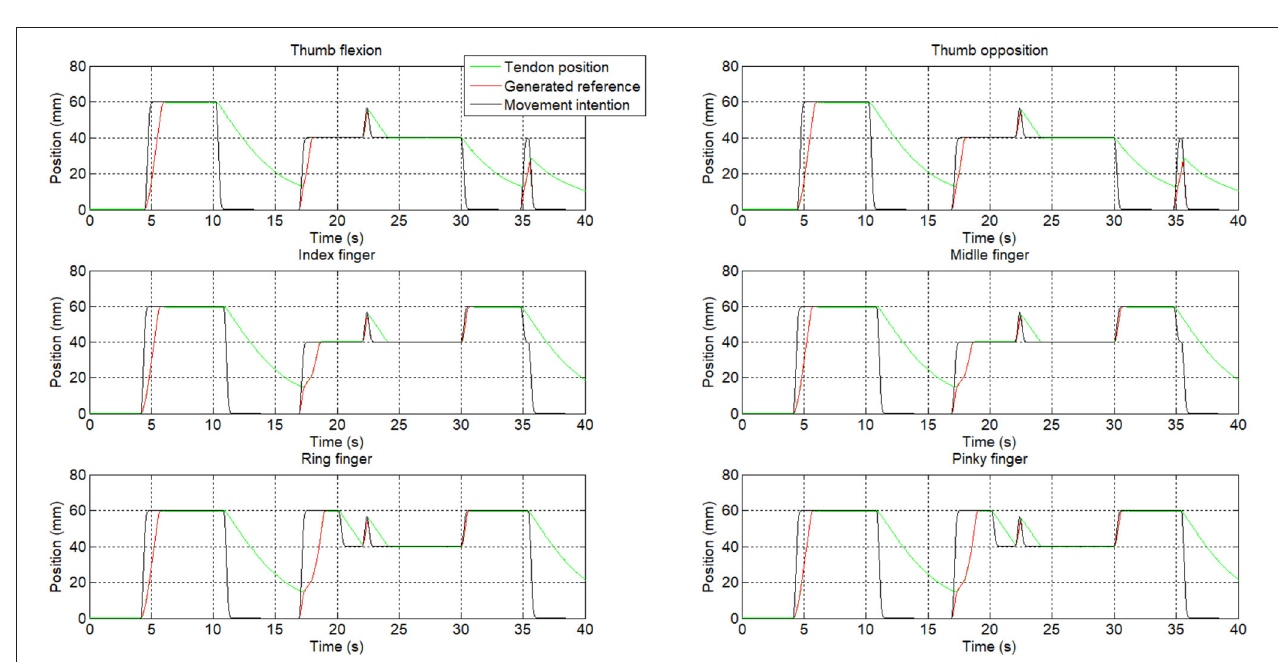
FIGURE 11 | Position response of the rehabilitation device.